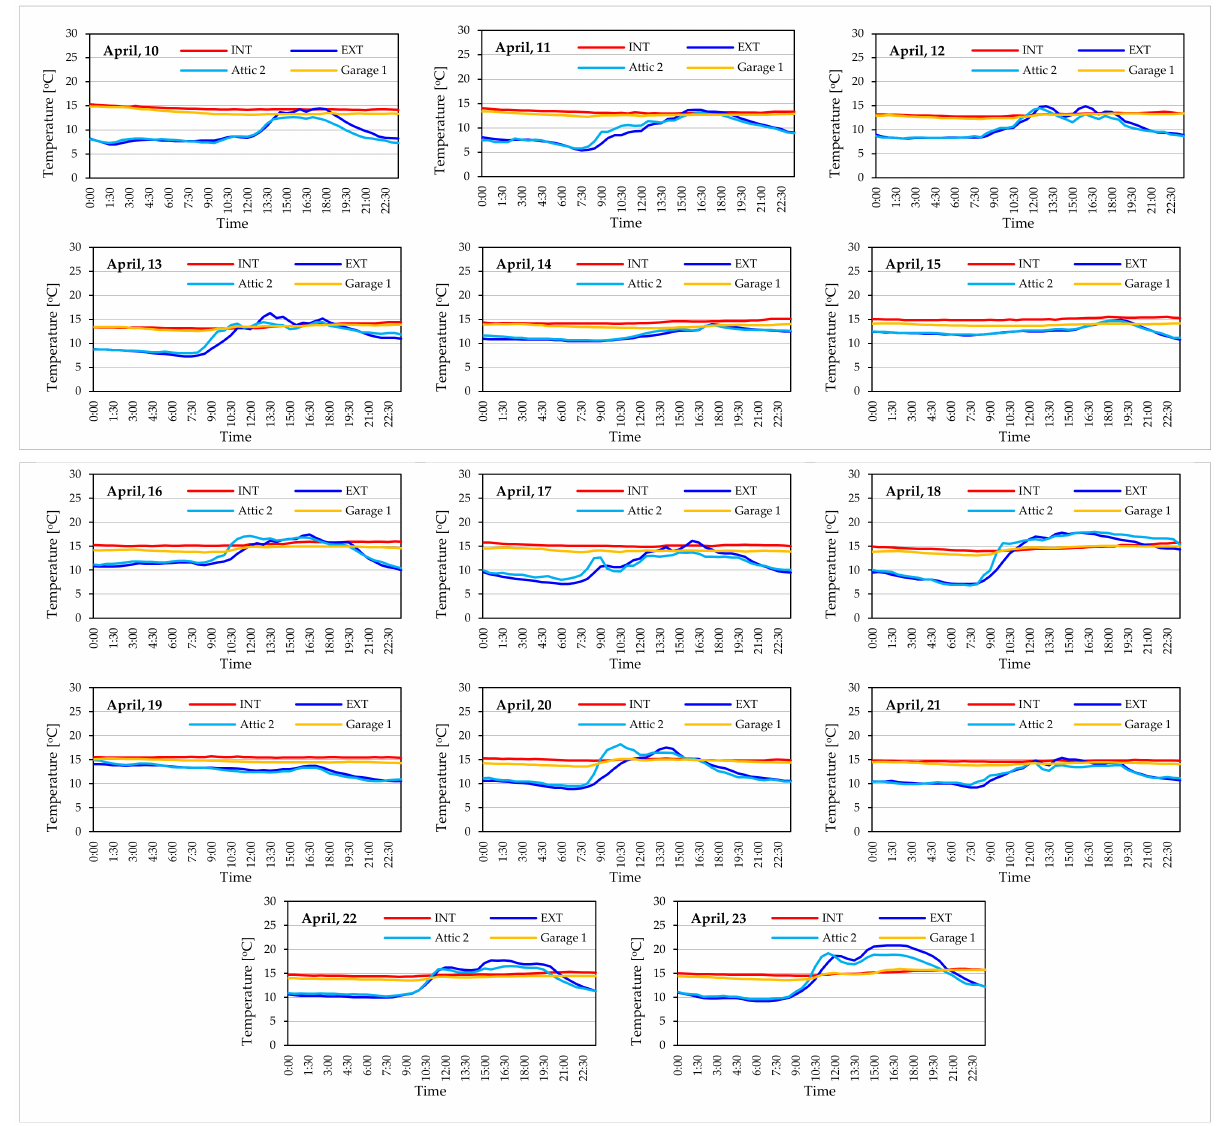
Figure 12. Daily temperature profile in Attic 2 and Garage 1.